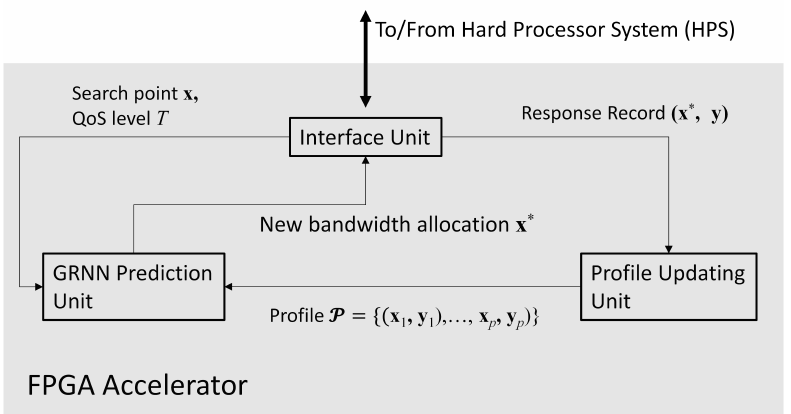
Figure 2. The architecture of the proposed FPGA accelerator. It can be separated into three parts: the GRNN prediction unit, the profile updating unit, and the interface